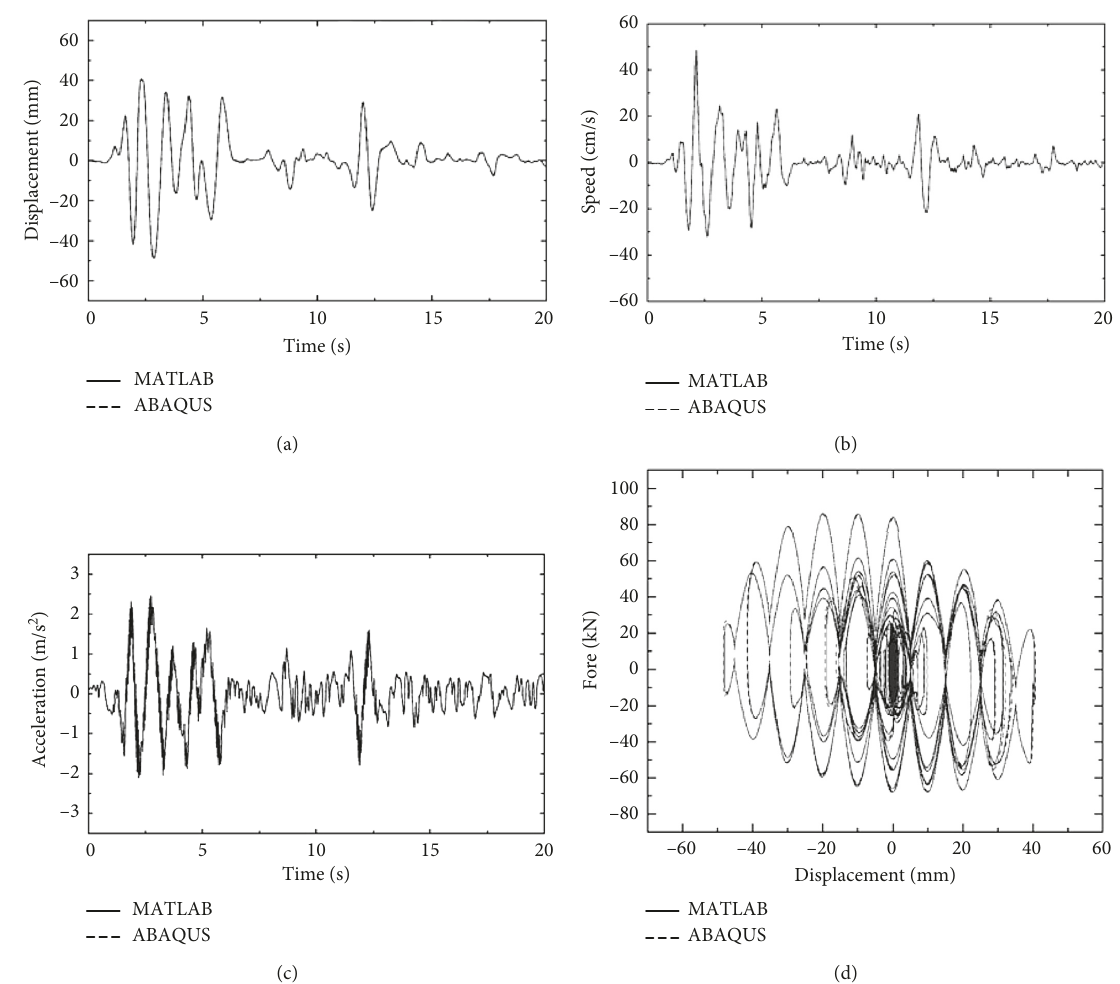
Figure 8: Comparison of time curves for SDOF system reaction: (a) displacement time history comparison; (b) speed time history comparison; (c) acceleration time history comparison; (d) CARD-VD hysteresis curve comparison.